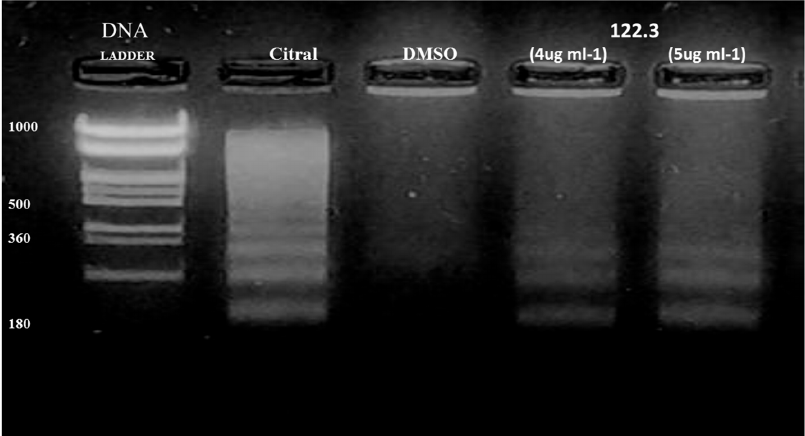
Figure 2. Analysis of genomic DNA fragmentation in BS-24-1 cells. 2.5 × 10 5 cells were incubated for 24 h with different concentrations of fraction 122.3. Lane 1, 1KB ladder; Lane 2, positive control (5 μ g/mL of citral for 1.5 h); Lane 3, negative control (DMSO); Lanes 4 and 5, cells treated with fraction 122.3 at the concentrations of 4 and 5 μ g/mL, respectively.